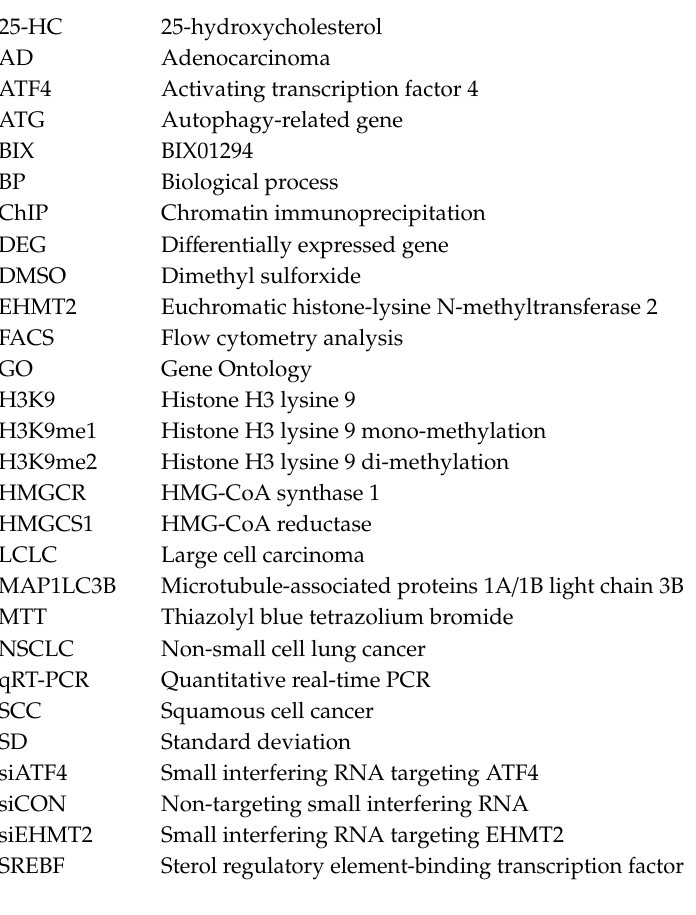
s1, Figure S1: Survival analysis in lung cancer depending on EHMT2 expression; Figure S2: Apoptosis induced by